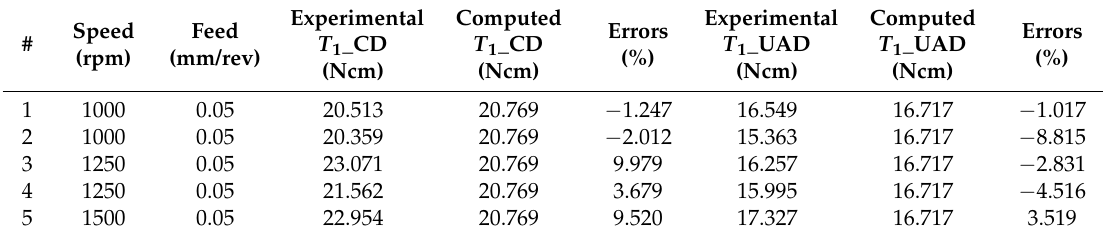
Table 2. Cutting torque T 1 from conventional drilling (CD) and ultrasonic assisted drilling (UAD) 190 experiments. 191